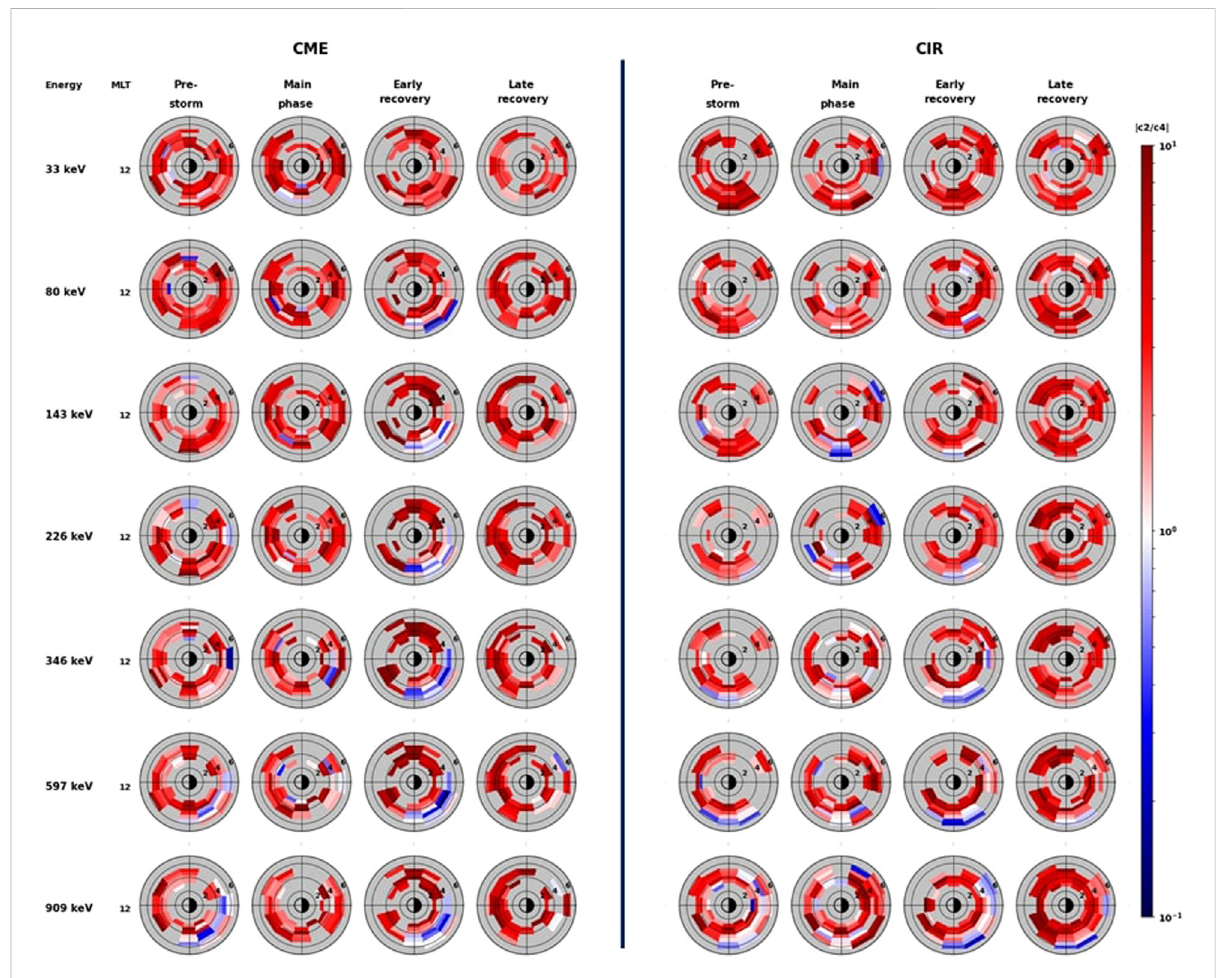
FIGURE 4 Comparison of the ratio R = | c 2 / c 4 | between CME-driven (left panel) and CIR-driven (right panel) geomagnetic storms. R is plotted in the same manner as in Figure 2, 3.